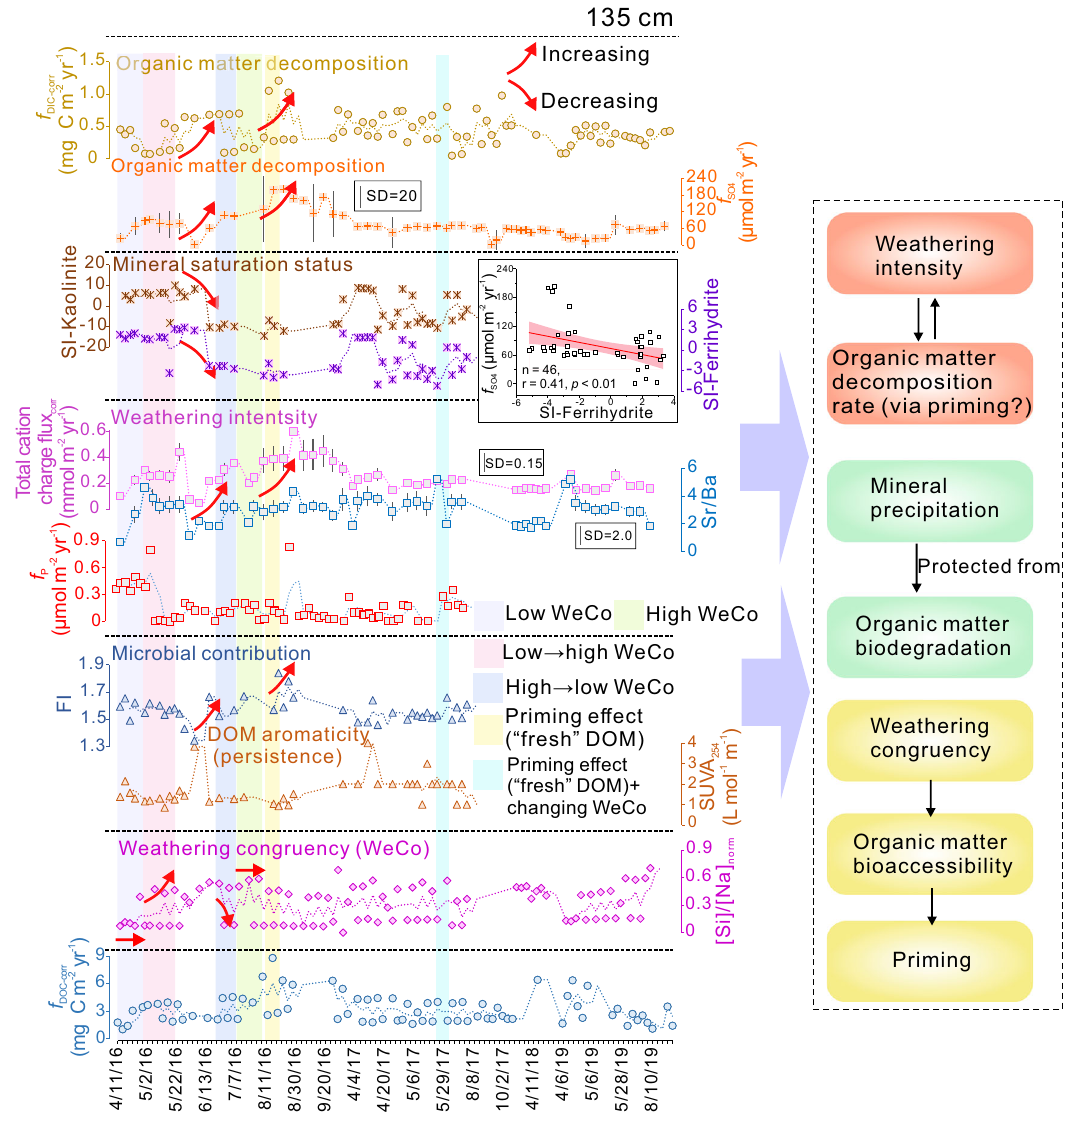
Fig. 3 | Time series of biogeochemical proxies at 135 cm depth. Proxies for mineral weathering intensity and weathering congruency display a degree of temporal coupling with saturation indices of secondary minerals. These proxies show generally consistent trends with organic matter decomposition rate. In the deep soil, fl uxes of SO 4 2 − and Cl − are suppressed by precipitation of secondary minerals. Fluorescence index (FI) shows an opposite trend to the parameter that de fi nes dissolved organic matter bioavailability. Fluxes of organic matter decom- position products are similar to the FI time series, suggesting that “ primed ” microbial activity accelerates organic matter decomposition. The periods with speci fi c biogeochemical characteristics are highlighted with background colors. For example, light purple, light green, pink, and blue bands represent the periods